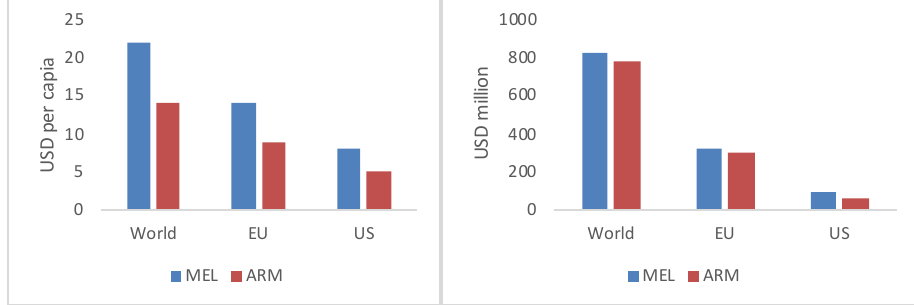
Source: Simulation results.